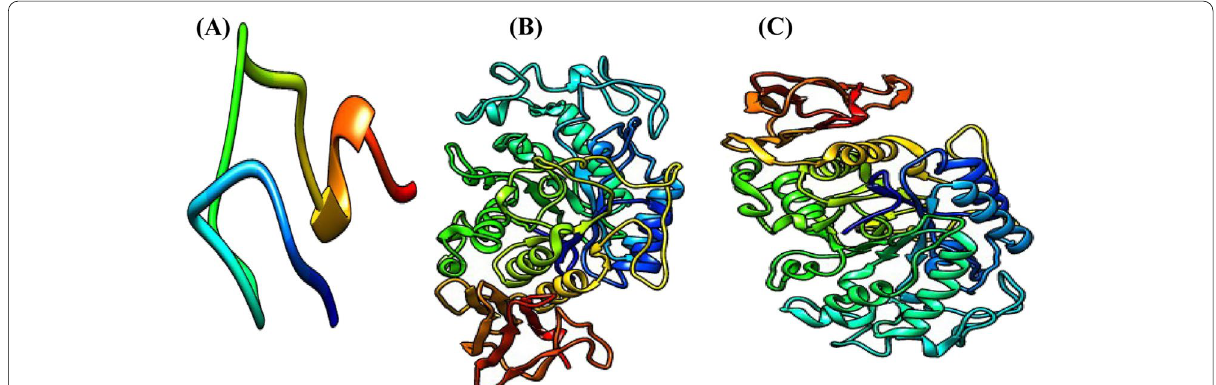
Fig. 3 Three-dimensional crystal structure of prepared proteins. (A) . FGF-21. (B) . Pancreatic α-amylase. (C) . Pancreatic